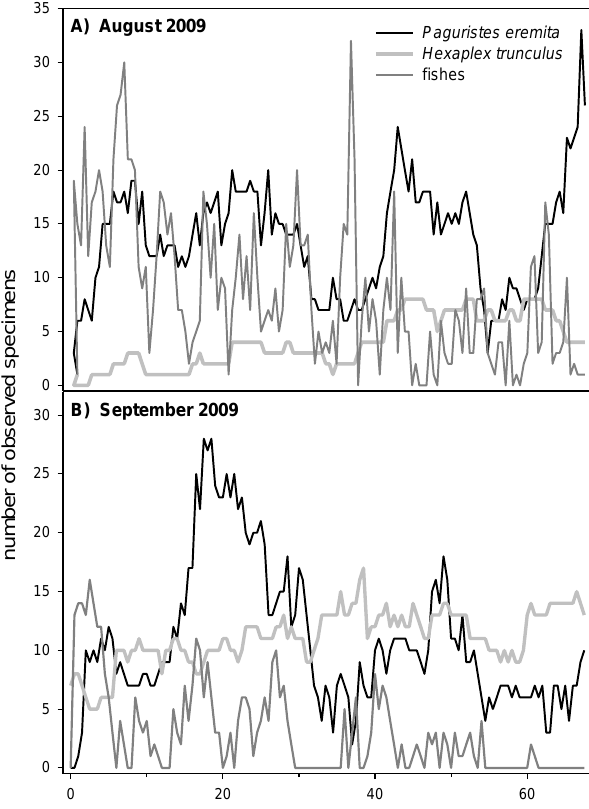
Fig. 2. (A) Arrival and presence of fishes, hermit crabs and gas- Figure 2: A) Arrival and presence of fishes, hermit crabs and gastropods after anoxia at the August 842 tropods after anoxia at the August 2009 plot and (B) September 2009 plot and B) September 2009 plot. 843 844 2009